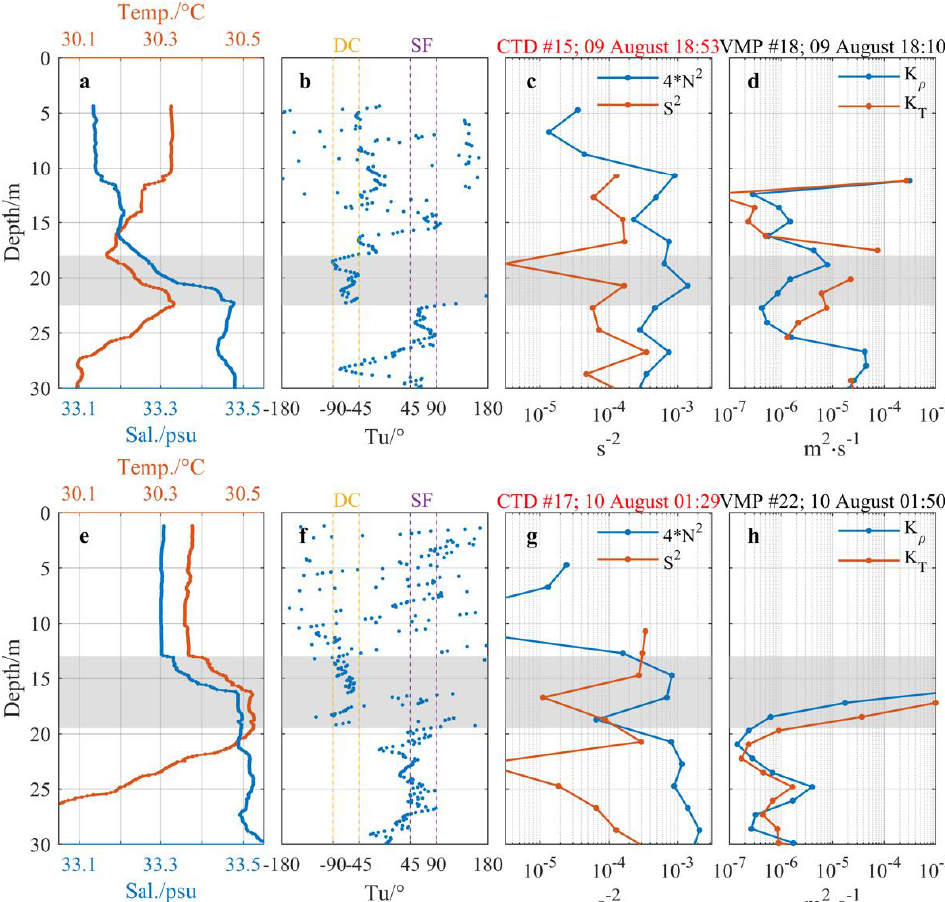
Figure 7. Two typical profiles as the two blue boxes marked in Figure 6b. Gray shadings indicate the temperature inversion layer. ( a , e ) Temperature (red lines) and salinity (blue lines). ( b , f ) Turner angle. Yellow dashed lines indicate the diffusive convection (DC) region. Purple dashed lines indicate the salt finger (SF) region. ( c , g ) The squared buoyancy frequency ( N 2 ) and the shear squared ( S 2 ). N 2 has been multiplied by a factor of 4 to comparison with the critical Richardson number (Ri = 0.25 or, equivalently, 4 N 2 = S 2 ). ( d , h ) The diapycnal diffusivities of density ( K ρ ) and heat ( K T ).